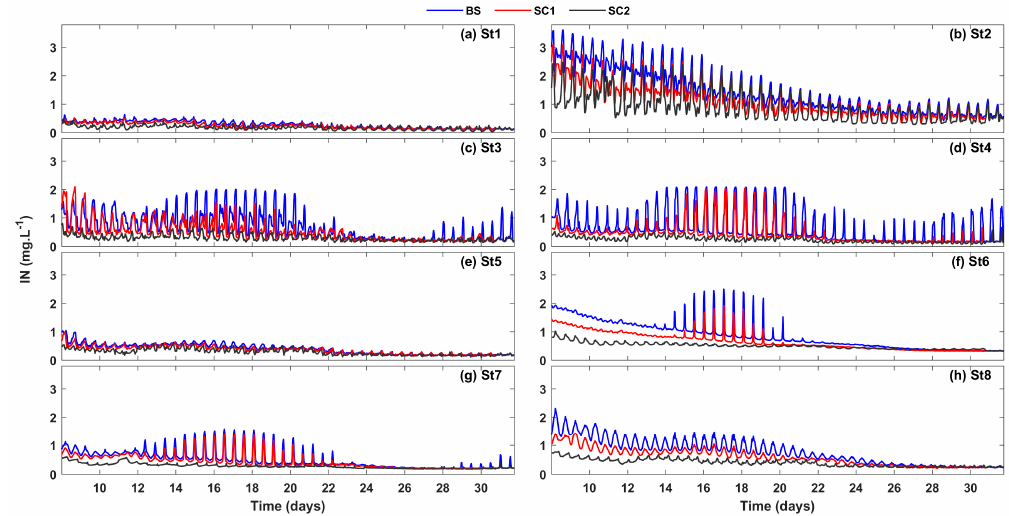
Figure 9. Time series of the inorganic nitrogen concentration (IN), for the scenarios, BS, SC1 and SC2, for September 2000, and the lagoon stations: ( a ) St1, ( b ) St2, ( c ) St3, ( d ) St4, ( e ) St5, ( f ) St6, ( g ) St7 and ( h ) St8.